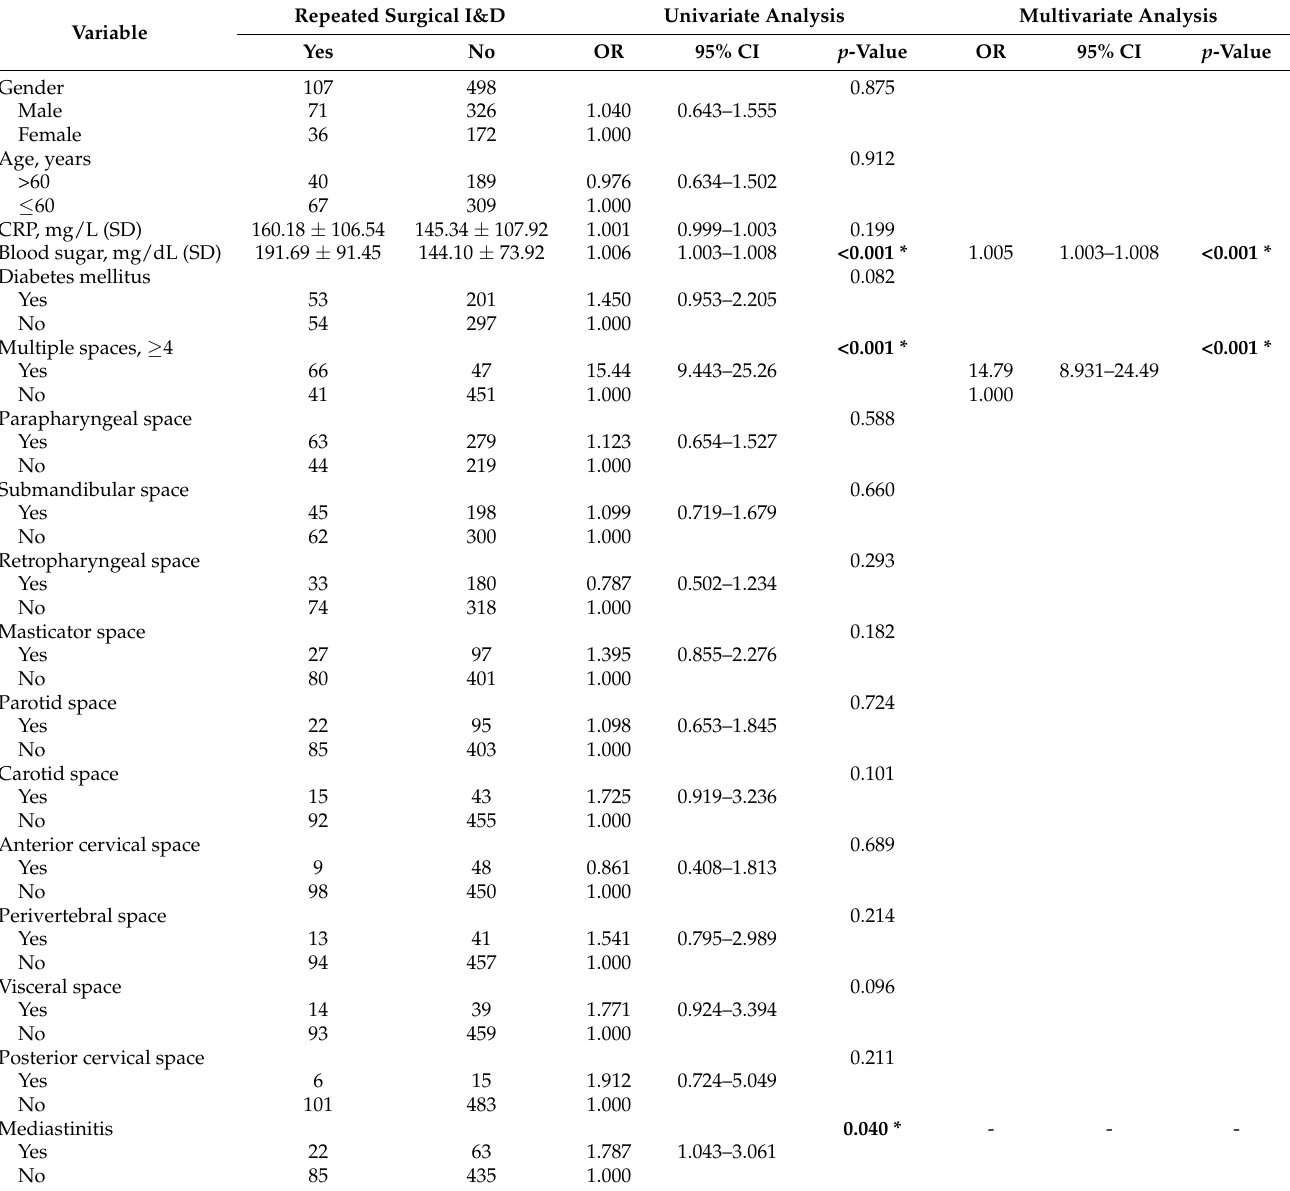
Table 2. Univariate and multivariate analyses of data concerning 107 patients who required repeat I&D and 498 patients who did not.